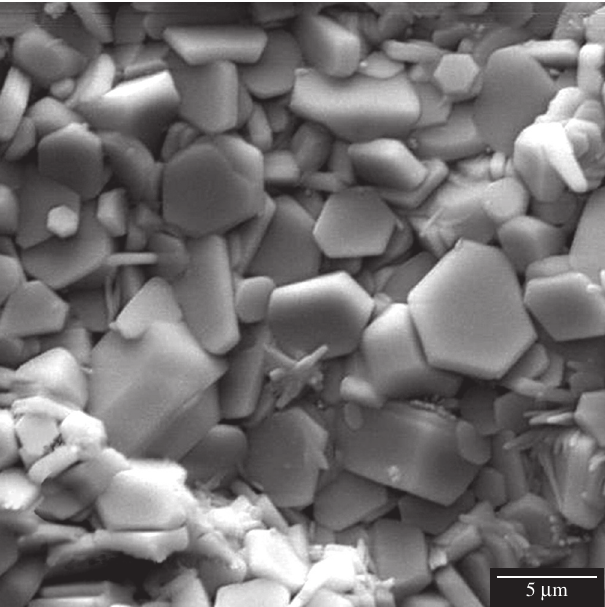
Figure 4. Fracture surface SEM microphotograph of Co 950 °C.